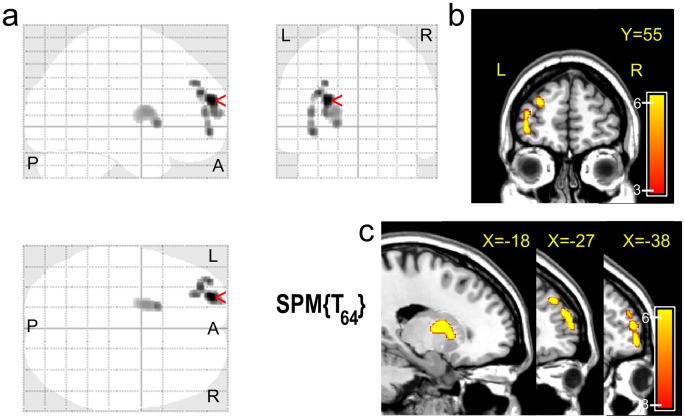
Anatomical regions with significant increases in white matter volume in treatment-naïve depressed patients relative to healthy subjects.Significance threshold with a family wise error (FWE) at p<0.05 and cluster size ≥20 voxels was used.